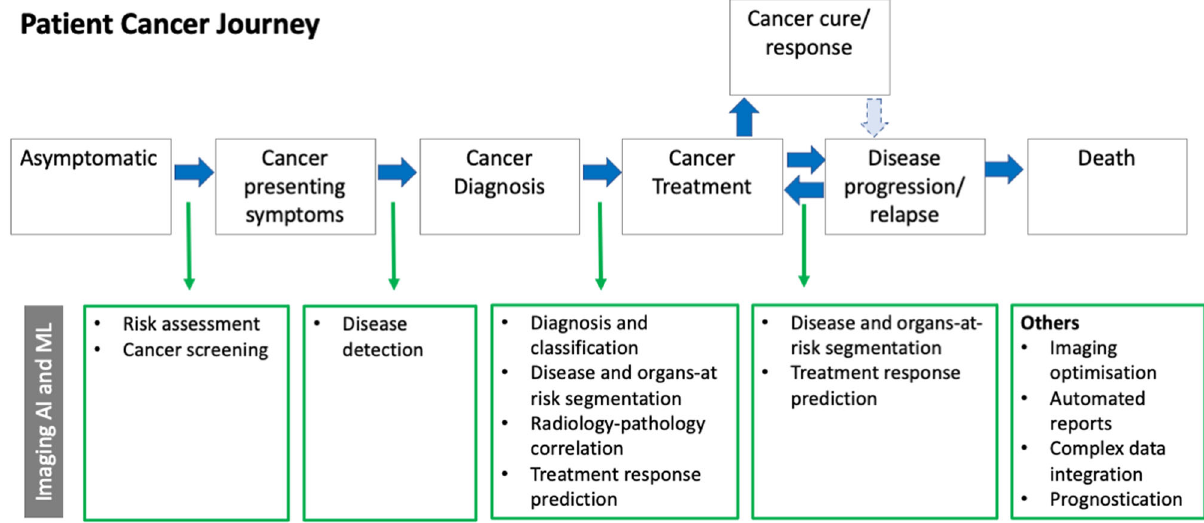
Fig. 3 Potential use cases for arti fi cial intelligence (AI) and machine learning (ML) in cancer imaging in relation to a patient ’ s cancer journey. A typical asymptomatic patient eventually develops cancer presenting symptoms, which usually leads to the cancer diagnosis. Following appropriate disease staging, cancer treatment commences, which can lead to good response or even cure. However, some patients will relapse or progress on treatment for which additional treatment may be administered. Unfortunately, some patients will succumb to their disease. The potential uses for Imaging AI and ML are as shown at various stages of the cancer journey and discussed in the